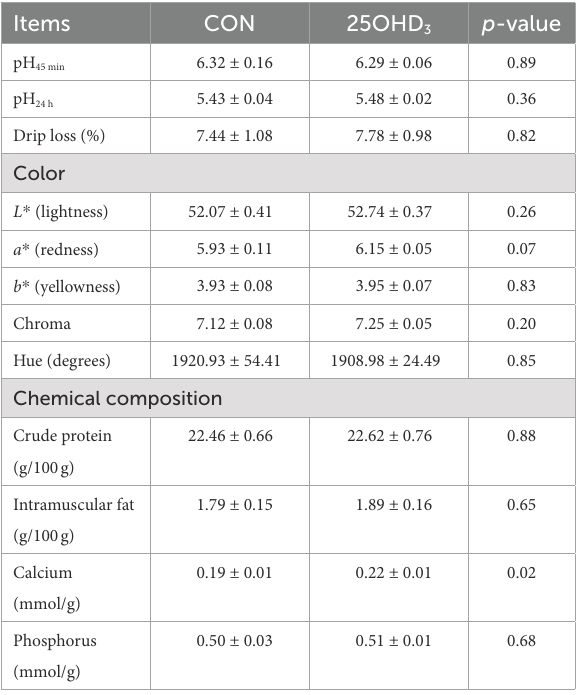
TABLE 5 Effects of 25OHD 3 supplementation on meat quality and chemical composition of longissimus dorsi